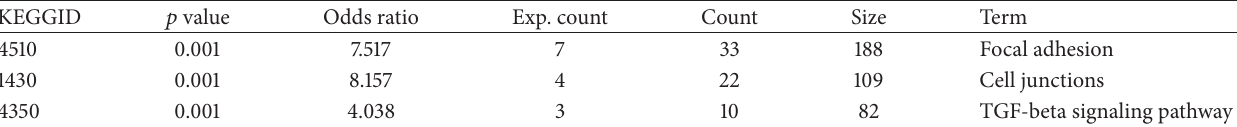
Table 3: Gene pathways based on the KEGG classification of a decreased expression in CD 34 − stem cells from umbilical cord blood. KEGGID 𝑝 value Odds ratio Exp. count